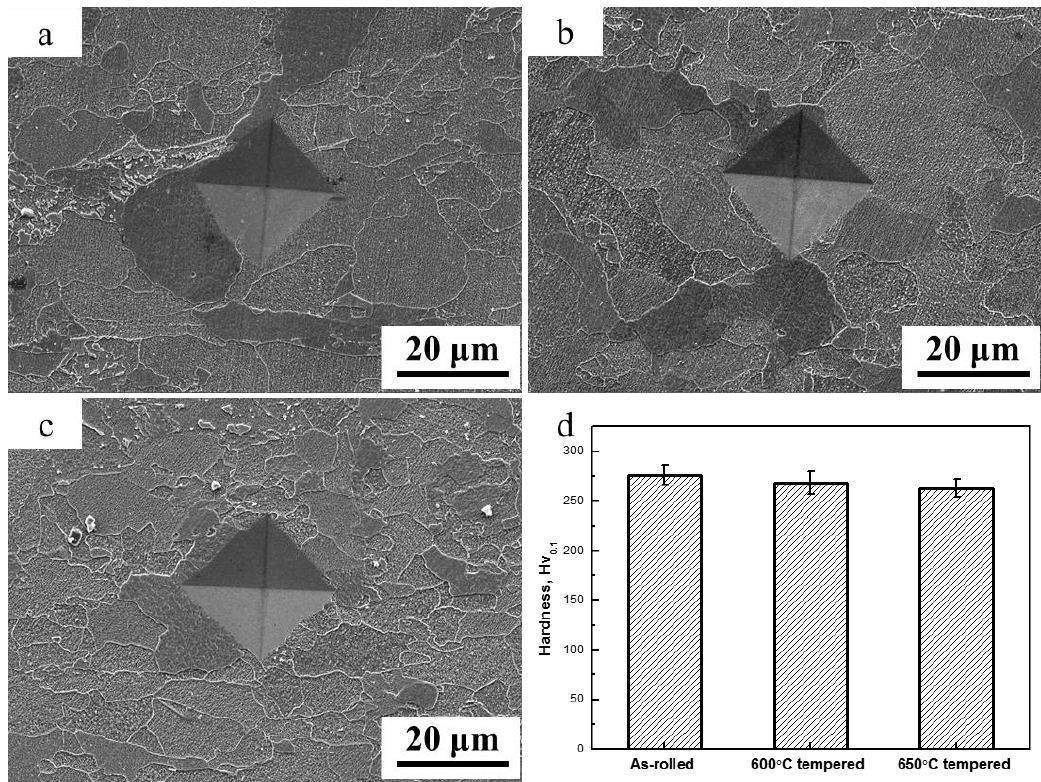
Figure 3. SEM images by secondary electron image mode showing a ferrite microstructure for samples after hot-rolling ( a ), holding at 600 °C ( b ) and 650 °C ( c ) for 3 h. ( d ) Microhardness plots for the studied steel.